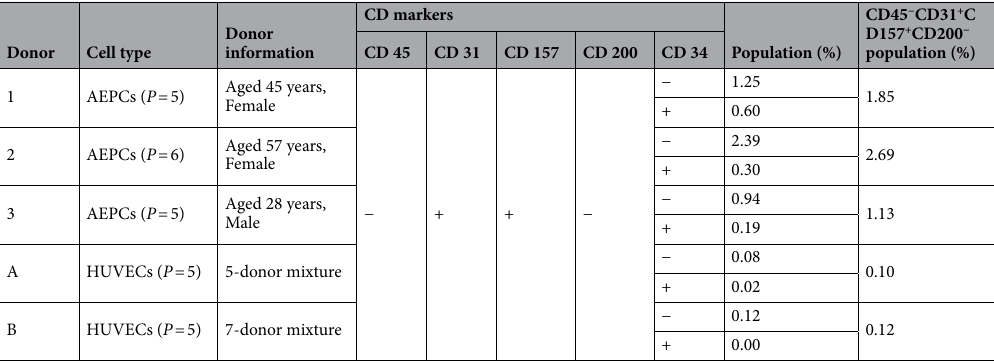
Table 2. List of the expression profiles of cultured AEPCs and